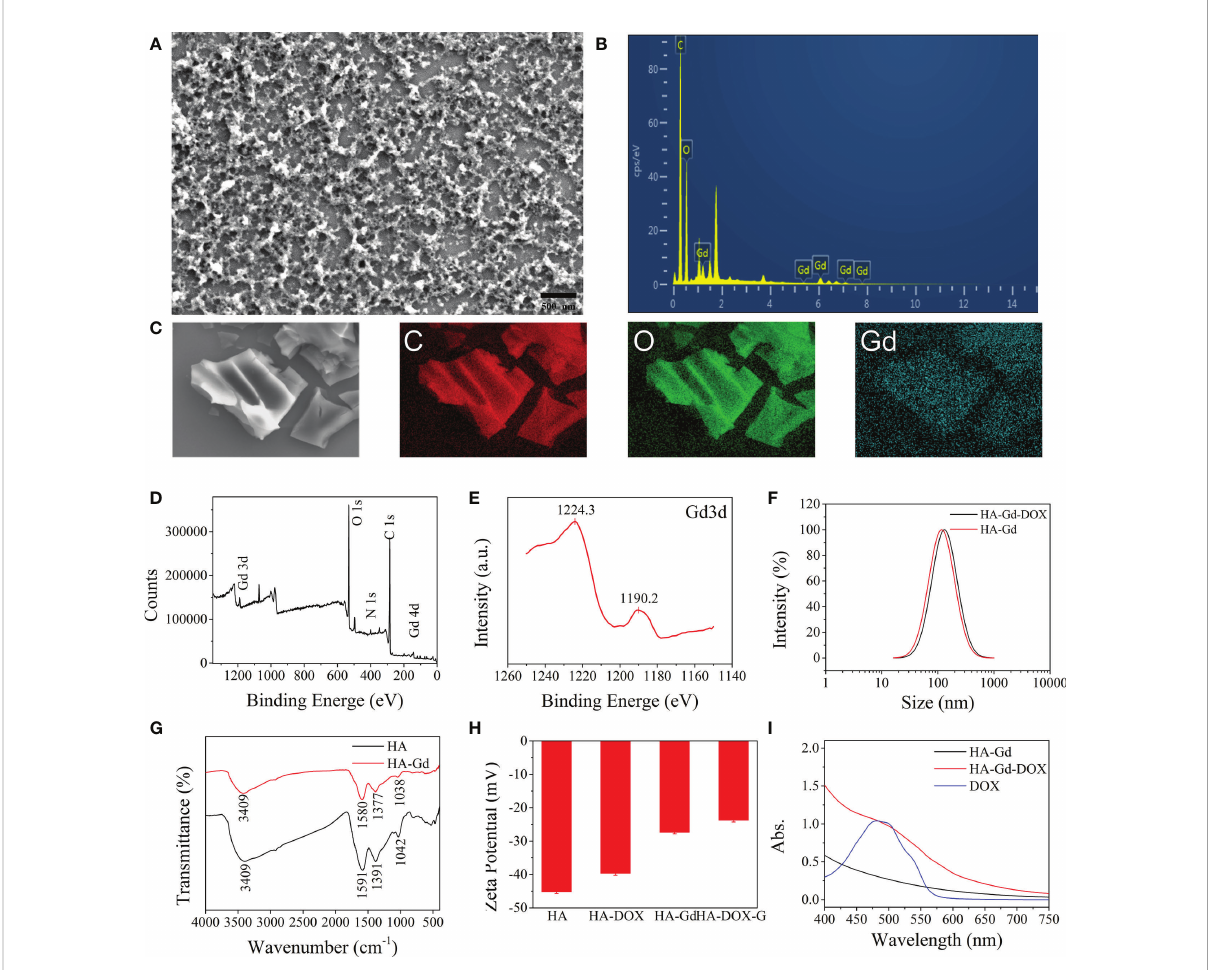
FIGURE 1 Characterization of the HA, HA-Gd, and HA-Gd-DOX. (A) SEM image of HA-Gd. (B) EDX of HA-Gd. (C) C, O, and Gd mapping images of HA-Gd nanocarriers. (D) XPS spectra of HA-Gd. (E) XPS spectra of Gd 3d orbit. (F) The DLS of HA-Gd and HA-Gd-DOX nanomaterials. (G) The FTIR spectra of HA and HA-Gd. (H) Zeta potential of HA, HA-DOX, HA-Gd, and HA-Gd-DOX. (I) UV-Vis spectra of HA-Gd, DOX, and